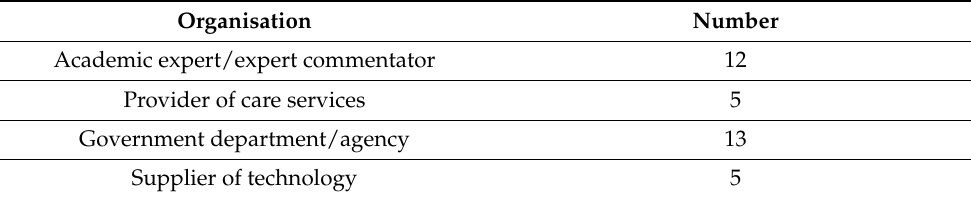
Table 2. Interviewees by